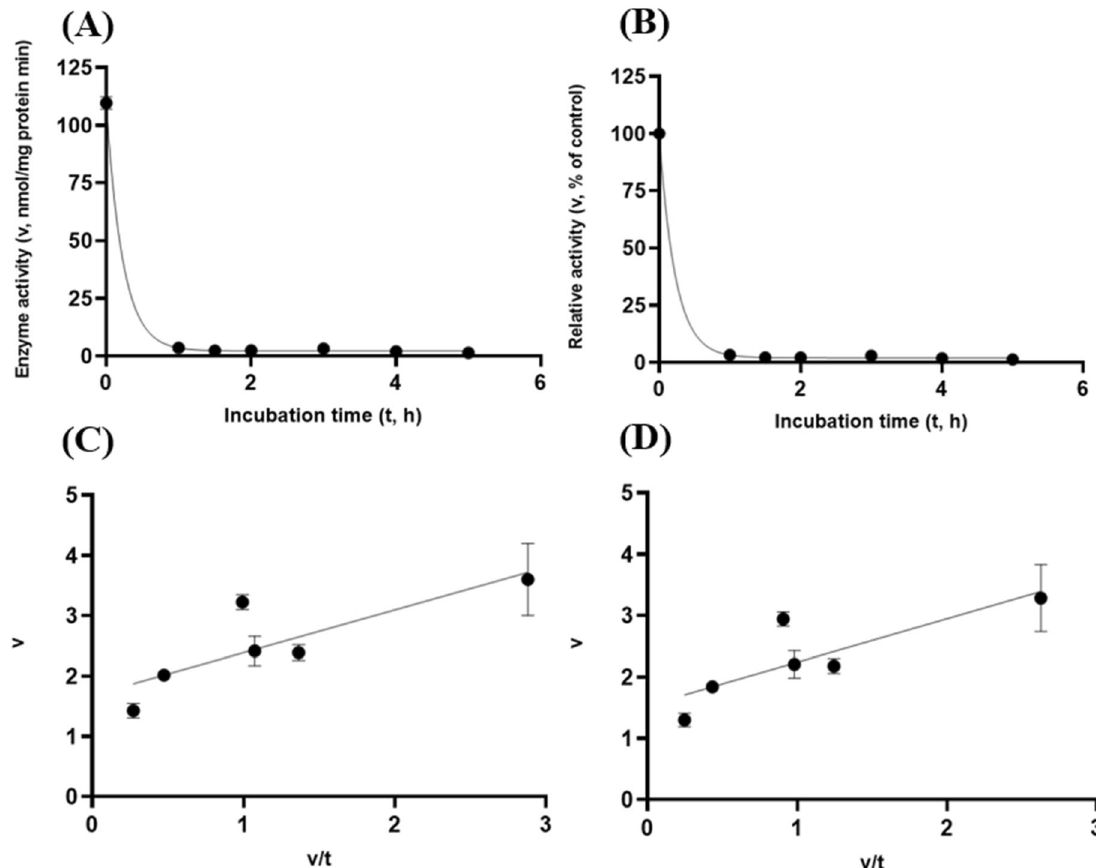
Figure 17. Experiment-3 of the intestinal pancreatic chymotrypsin (20 U/mL) effects (with describing model parameter estimates ± SE ) on GH5-p4818Cel5_2A activity over a 5-h period after the intestinal pancreatic chymotrypsin buffer being mixed with the heat-treated enzyme preparation for incubation at the resulting mixture pH = 6.0–7.0 and chymotrypsin (20 U/mL) prior to further incubation for measuring cellulase activity with the carboxymethyl cellulose (CMC) substrate buffer in presence of dithiothreitol (DTT) (5 mM) and N 2 gas purging for 15 min at 37 °C. (A) Plot of the inhibition kinetic relationship between the GH5- p4818Cel5_2A activity (v, mean ± SE, n = 12at each time point, nmol/mg protein•min) and incubation time (t, h) established according to the exponential response model as: Y = 250.7 ( ± 16.314 ) e [ − 3.263 ( ± 0.255 ) x ) ]